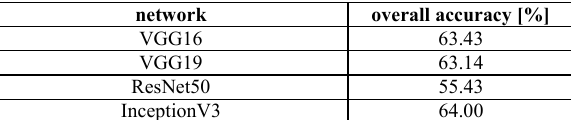
Table 1. Highest achieved overall accuracies of different CNNs on our balanced 5-class test set. All networks have been